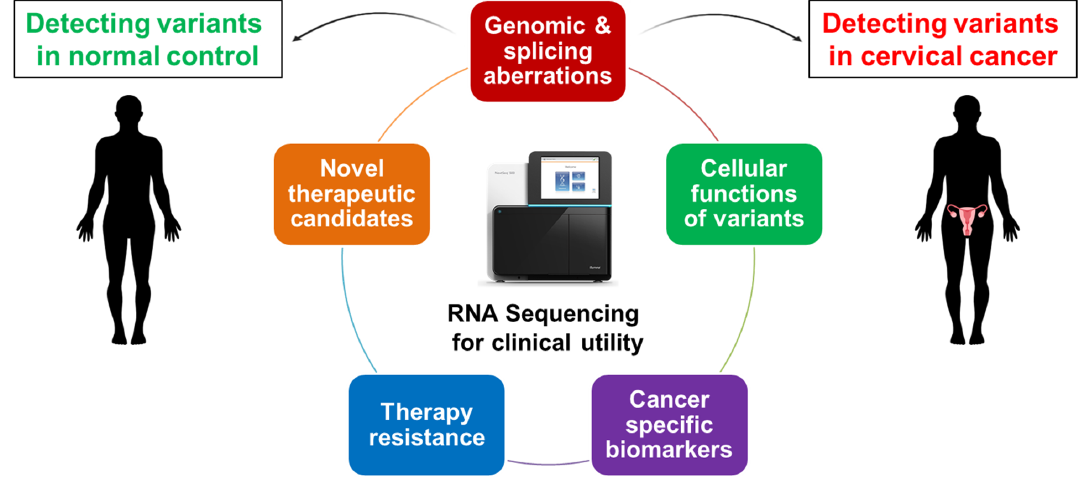
Figure 7. Overview of clinical biomarker identification. Aberrant alternative splice variants are often expressed in significantly higher levels compared with normal splice variants that can be identified through next generation sequencing (NGS). These aberrations can contribute to the development of tumourigenesis, therapy resistance, and poor prognosis. The effects of aberrant alternative splicing can be addressed by identifying cervical cancer-specific genomic and splicing aberrations that are clinically relevant for novel diagnostic, prognostic, and therapeutic purposes [24,81].